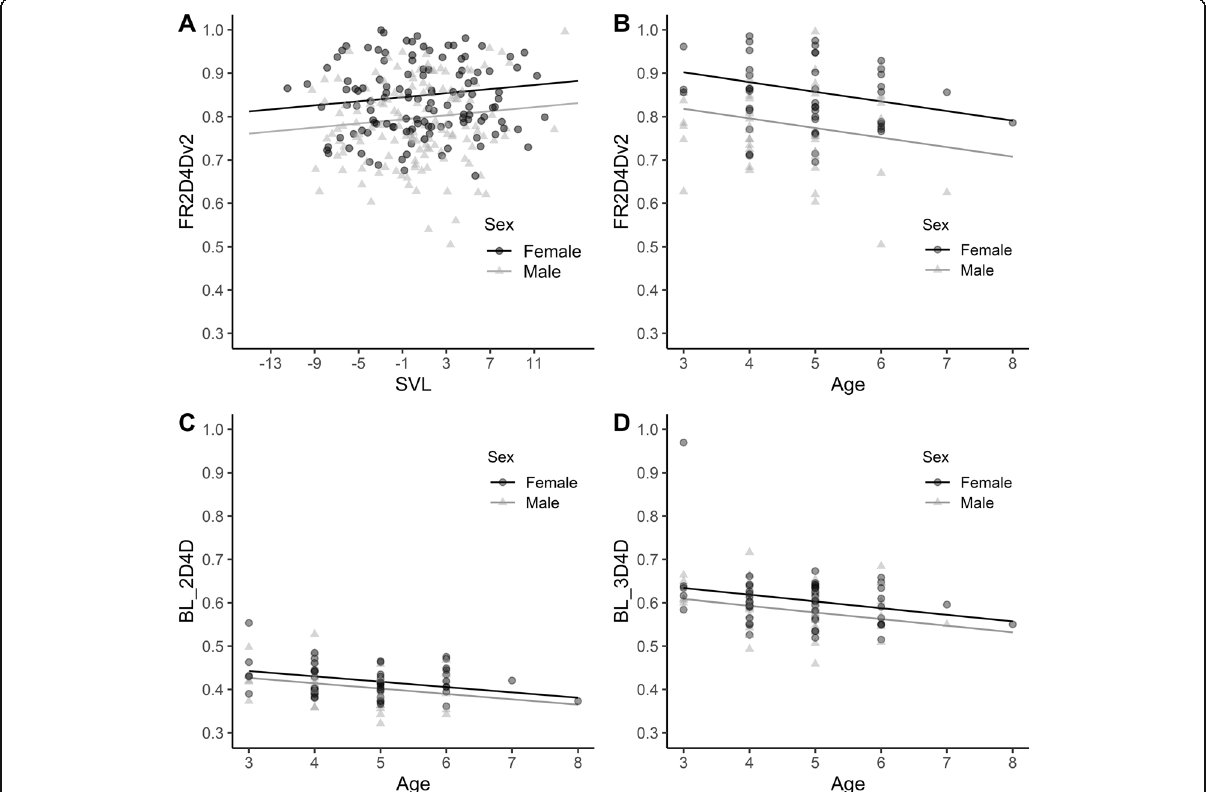
Fig. 2 Panel a : relationship between size (SVL, snout-vent length) of the common toad Bufo bufo and right forelimb 2D:4D (variant II) for each sex (for each individual, SVL was centered around the mean size for its sex); Panel b : relationship between age (determined using skeletochronology) and right forelimb 2D:4D (variant II) for each sex; Panel c : relationship between age and left hindlimb 2D:4D for each sex; Panel d : relationship between age and left hindlimb 3D:4D for each sex. Age results were obtained from the second dataset containing only individuals from site 2 ( N = 99; individuals after 3, 4, 5, 6, 7, or 8 hibernations. For more details, see Fig.